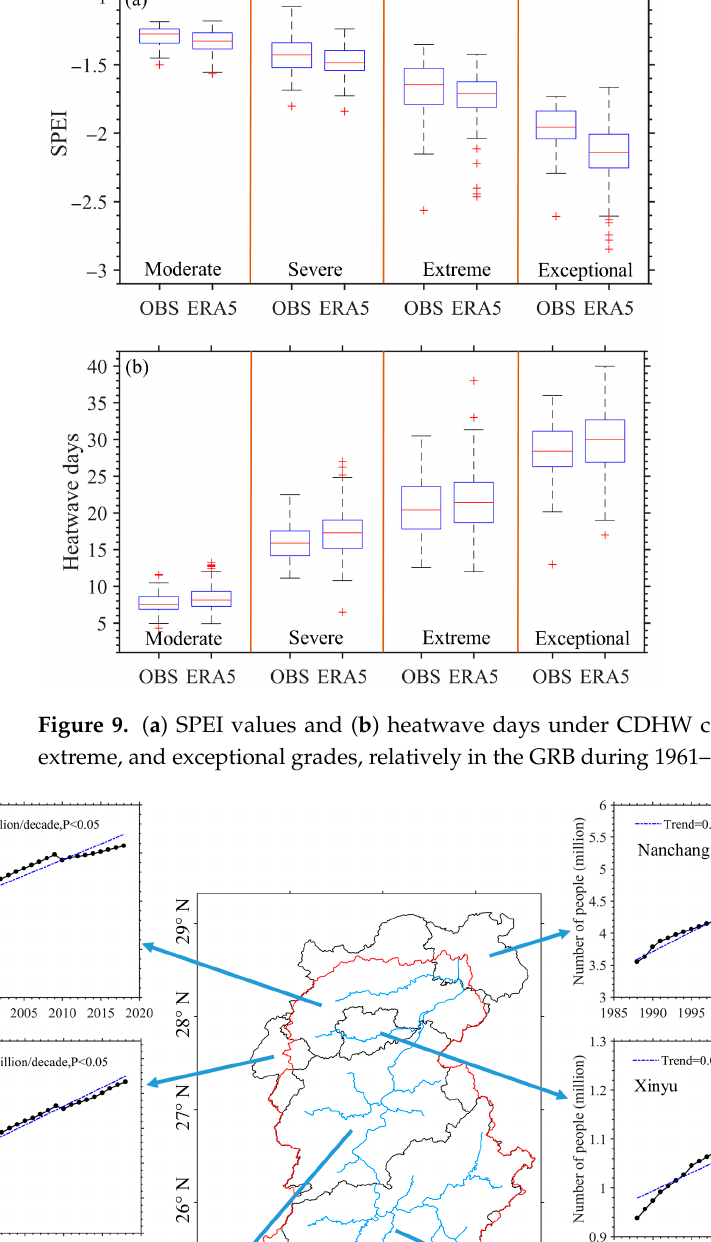
Figure 8. Empirical CDF of the CDHMI for all the CDHWs at all the stations/grids in the observa- tion/ERA5 in the GRB from 1961 to 2018.